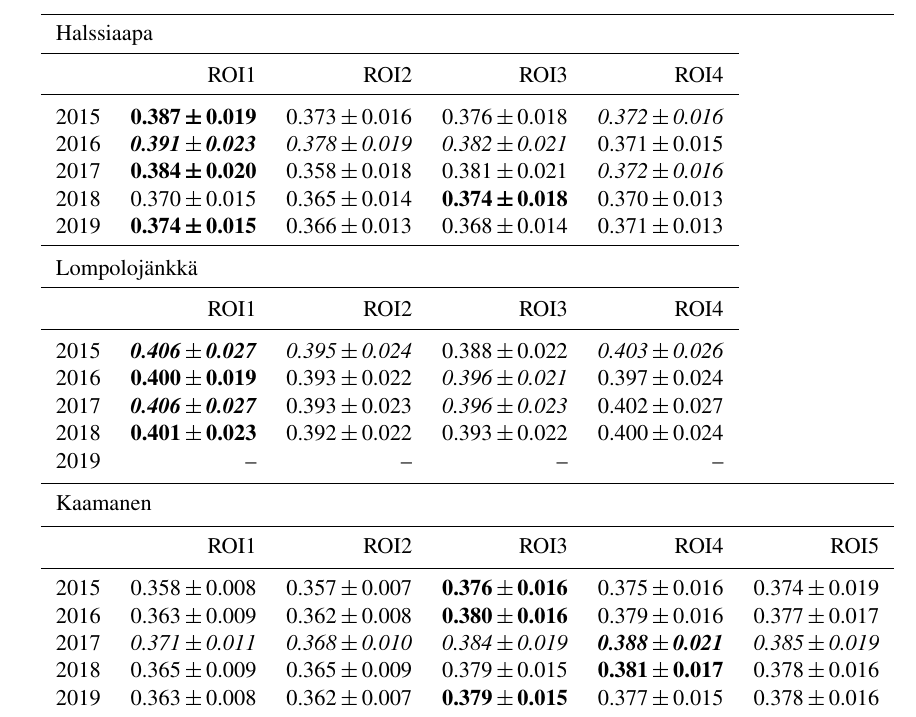
Figure 7. Development of GCC and GPP max from 1 May to 30 September in 2015–2019 at Halssiaapa. Different symbols and colours denote different years, and the bands show the 95% confidence intervals of the fitted double hyperbolic tangent function. The red dots indicate the fixed start and end days defined for the fitting. Table 4. The maximum GCC values of different plant communities characterized by the dominant species specified in Table 1 (defined as image ROIs) from 2015 to 2019. The maximum value among different ROIs is marked as bold, and the maximum among the years is italic. The values marked as bold and italic describe the value being both maximum among the ROIs as well as the measurement years. The ROIs are described in Sect. 2.4. The data from Lompolojänkkä are missing in